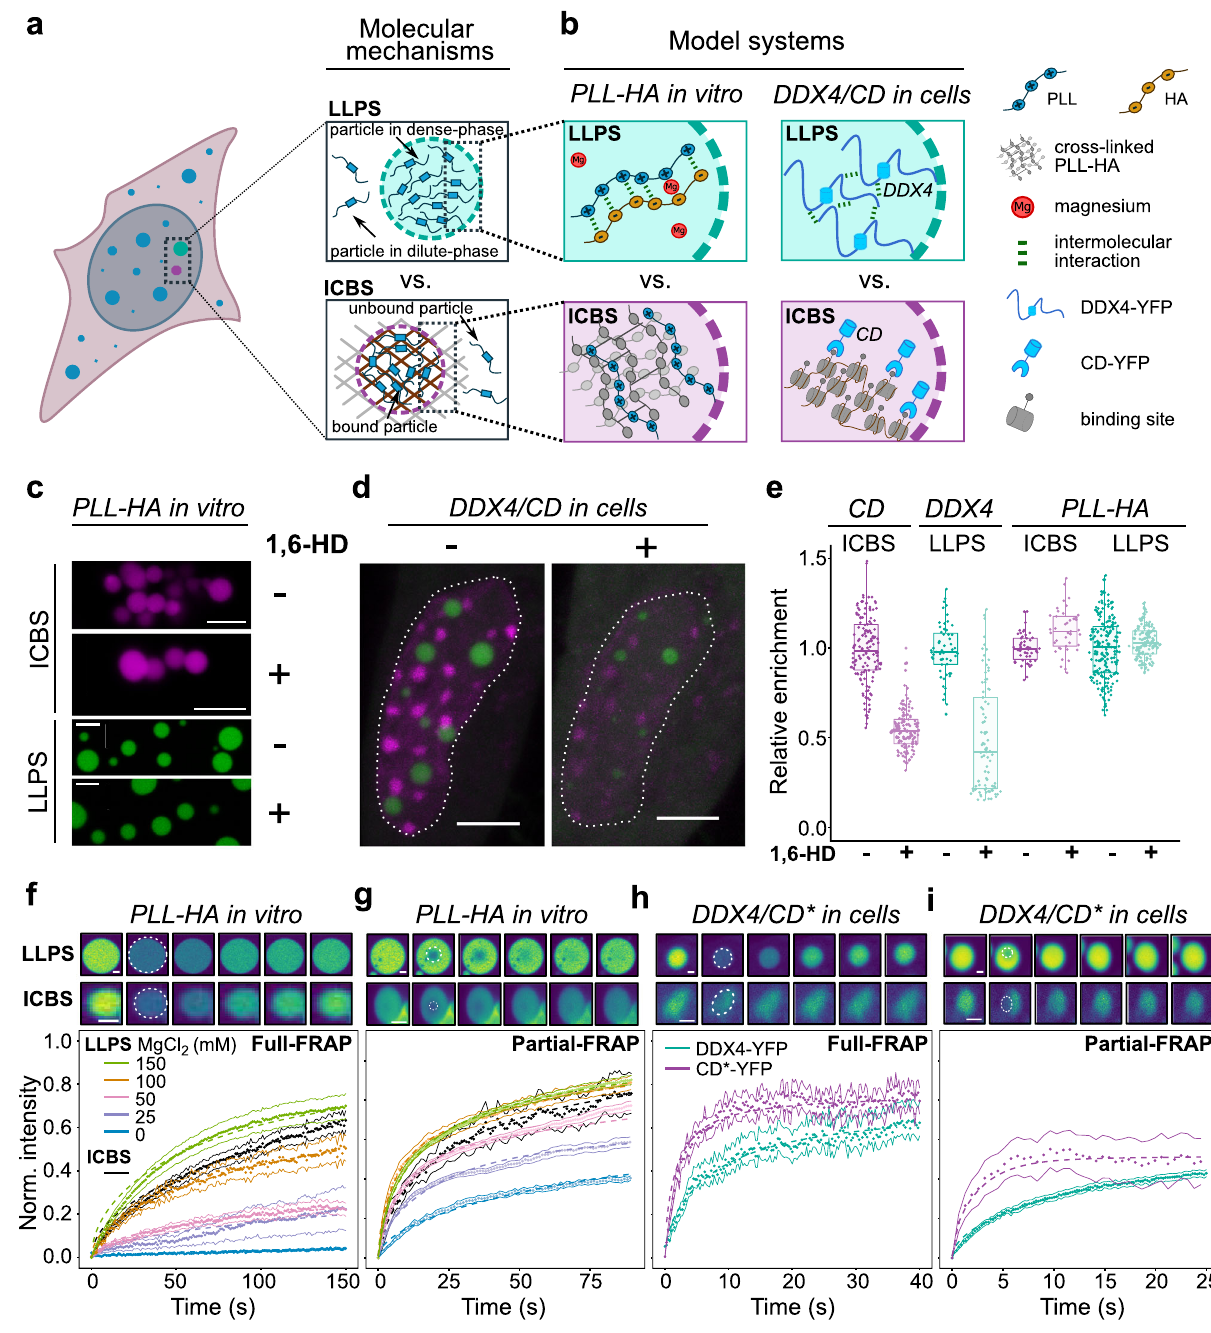
Fig. 1 | Benchmarking 1,6-hexanediol treatment and classical FRAP using well- de fi ned model systems. a Schematic representation of membrane-less structures formed by LLPS (top) or ICBS (bottom). b Schematic representation of the model systems used inthiswork: PLL-HAcoacervatesundergoing LLPS invitro(top, left), PLL undergoing ICBS in vitro (bottom, left), DDX4-YFP undergoing LLPS in living cells (top, right) and the chromodomain of CBX1/HP1 β undergoing ICBS at peri- centric heterochromatin enriched for H3K9me2/3 (bottom, right). c , Microscopy images of PLL-HA coacervates (green) and PLL undergoing ICBS (magenta) in the absence or presence of 1,6-hexanediol. Scale bars, 5 µ m. d Microscopy images of a living cell expressing DDX4-YFP and CD-mKate, in the absence or presence of 1,6-hexanediol. Scale bars, 5 µ m. e Quanti fi cation of PLL-FITC, DDX4-YFP and